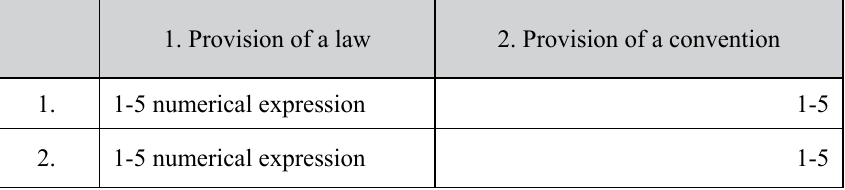
Table 1. expert evaluations numerical